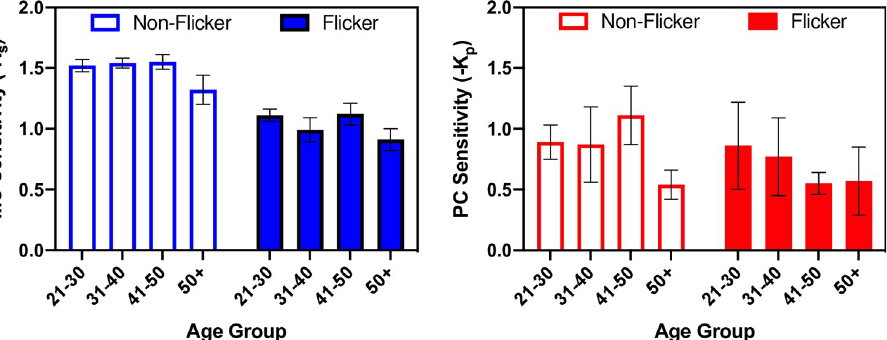
Fig 4. Averaged contrast sensitivity parameter data (Mean and SD) for the MC and PC pathways by age